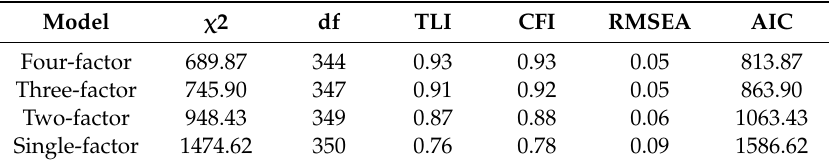
Table 1. Confirmatory factor analysis